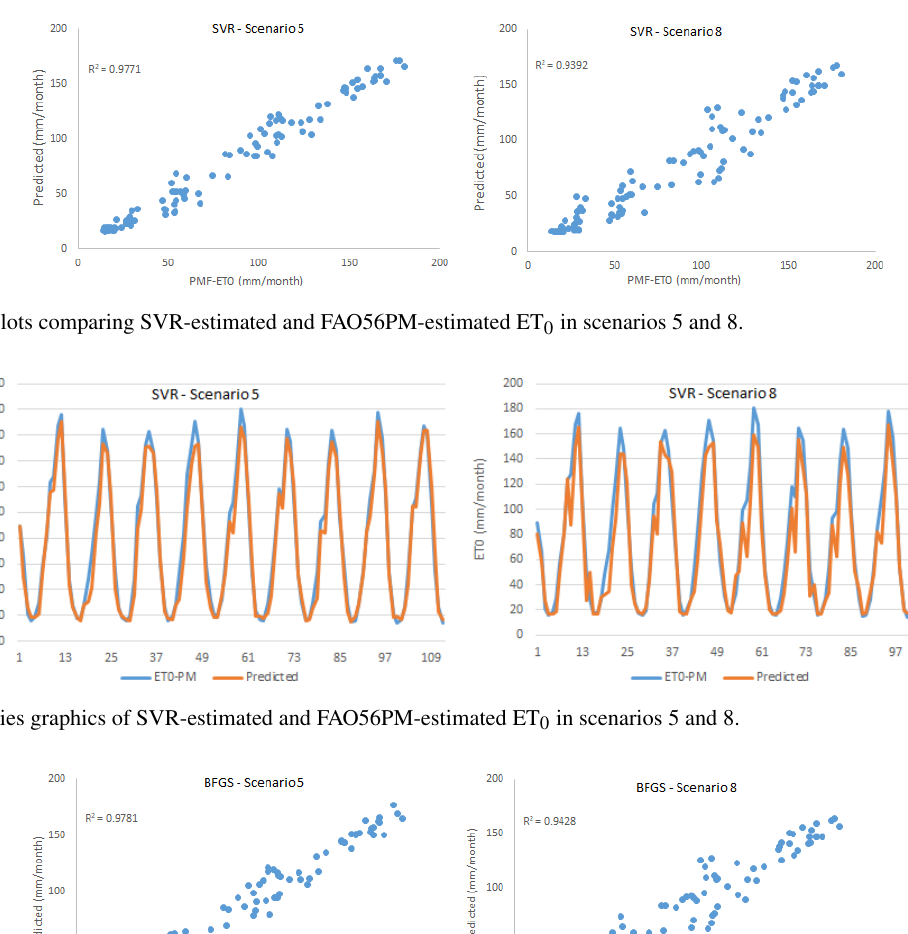
month; testing period: R 2 = 0 . 9781, MAE = 6.7885